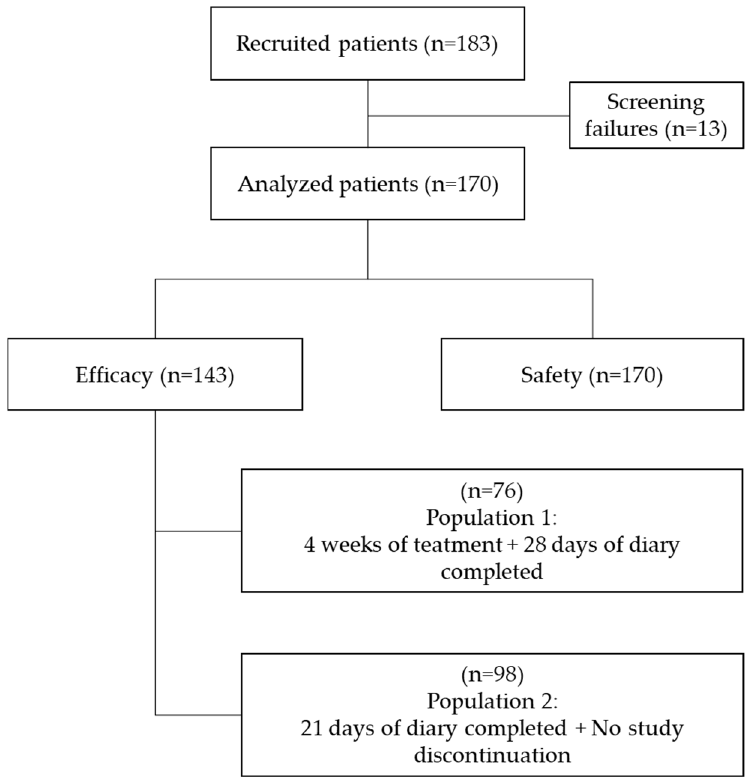
Figure 1. Disposition of subjects.